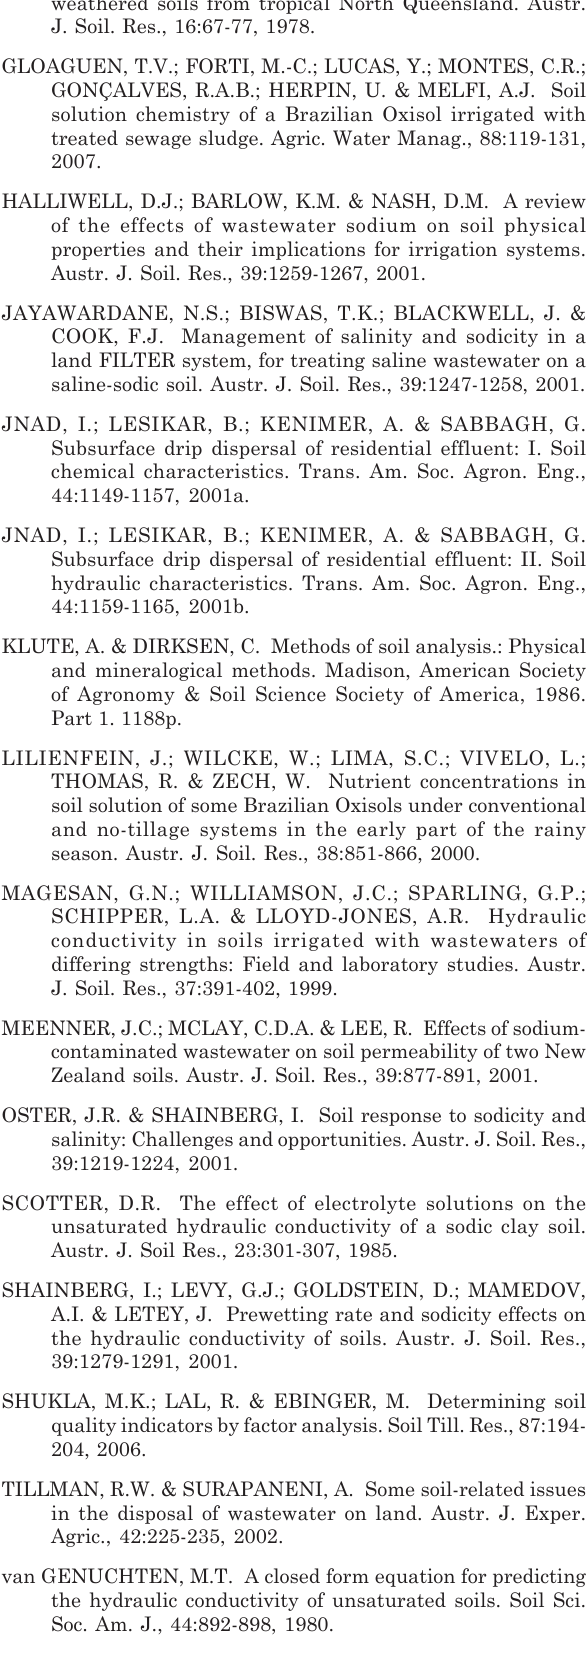
Table 7. Effect of soil depth on factor scores